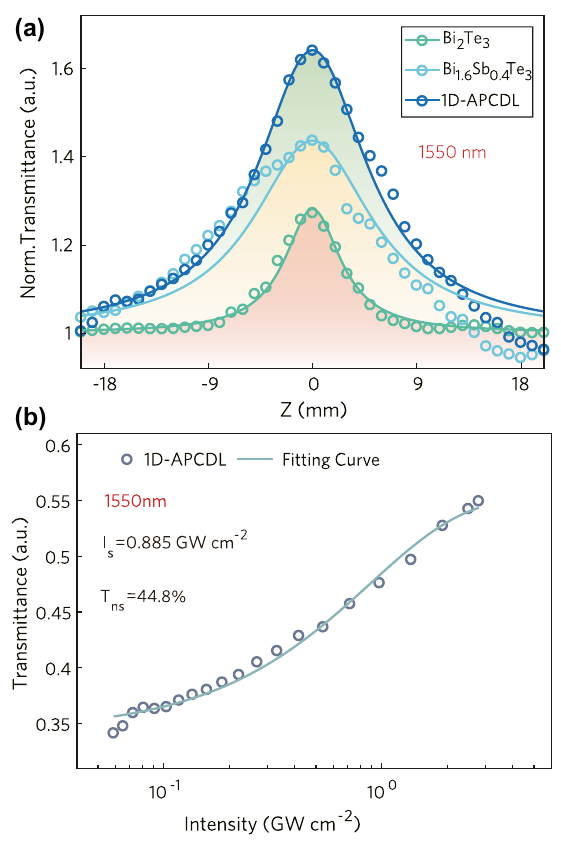
Figure 6: Nonlinear characteristic of 1D-APCDL. (a) Z-scan comparison of three samples, (b) the modulation depth curve of